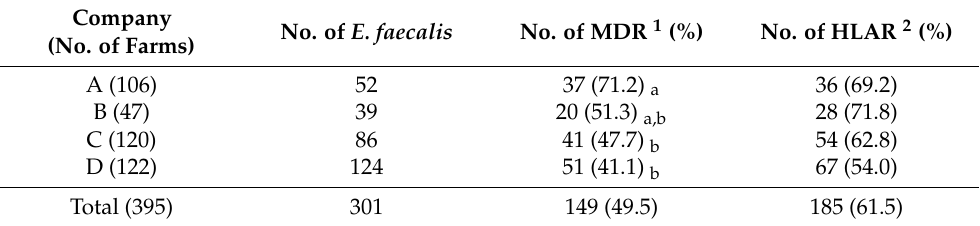
Table 2. Distribution of multidrug-resistant and high-level aminoglycoside-resistant Enterococcus faecalis isolates from the bulk tank milk of four dairy companies. Company